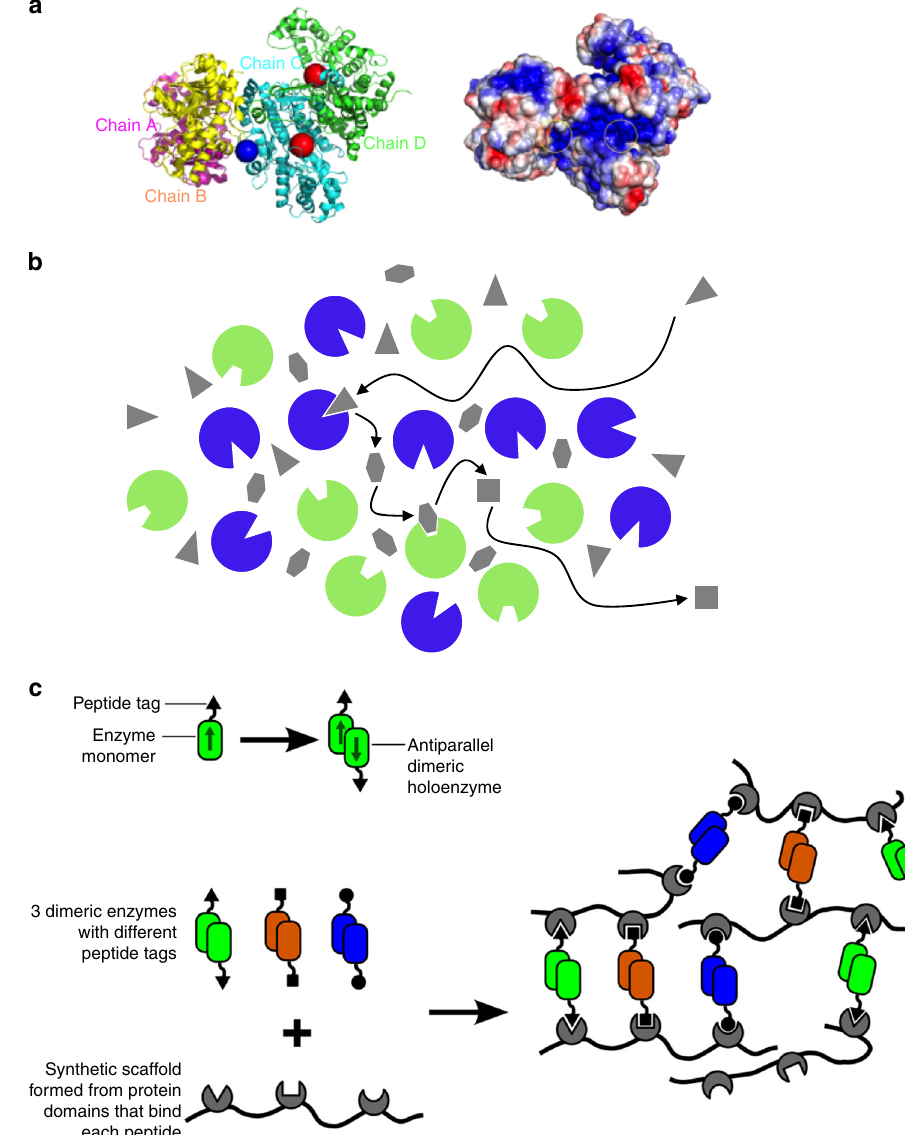
Fig. 2 Mechanisms of substrate channelling in dynamic enzyme assemblies. a Direct channelling by electrostatic retention of the channelled metabolite on the surface of the enzyme complex. A structural model of the bovine malate dehydrogenase (MDH) – citrate synthase (CS) complex is shown. On the left, the polypeptides are illustrated as ribbon diagrams, with the MDH dimer shown in magenta and yellow and the CS dimer show in green and cyan. The blue circle shows where OAA molecules were initially placed in a Brownian dynamics simulation. Red circles show the active sites in the CS dimer. On the right, the surface structure of the complex is shown, with red and blue colours representing negative and positive electrostatic potential, respectively. Neutral regions are shown in white. Yellow circles indicate the positions of the adjacent MDH and CS active sites. b Probabilistic channelling within a large cluster of enzymes. Two enzymes are shown as green and blue circles. Metabolites are shown as grey polygons, with each shape representing a different metabolite. The arrows indicate the path taken by metabolites in a sequential conversion event by two enzymes. c Mechanism of enzyme cluster formation in synthetic scaffold-enzyme assemblies. When oligomeric enzymes are docked onto synthetic protein scaffolds via peptide tags, then interaction with more than one scaffold molecule are possible leading to the formation of a large aggregation of scaffolded enzyme